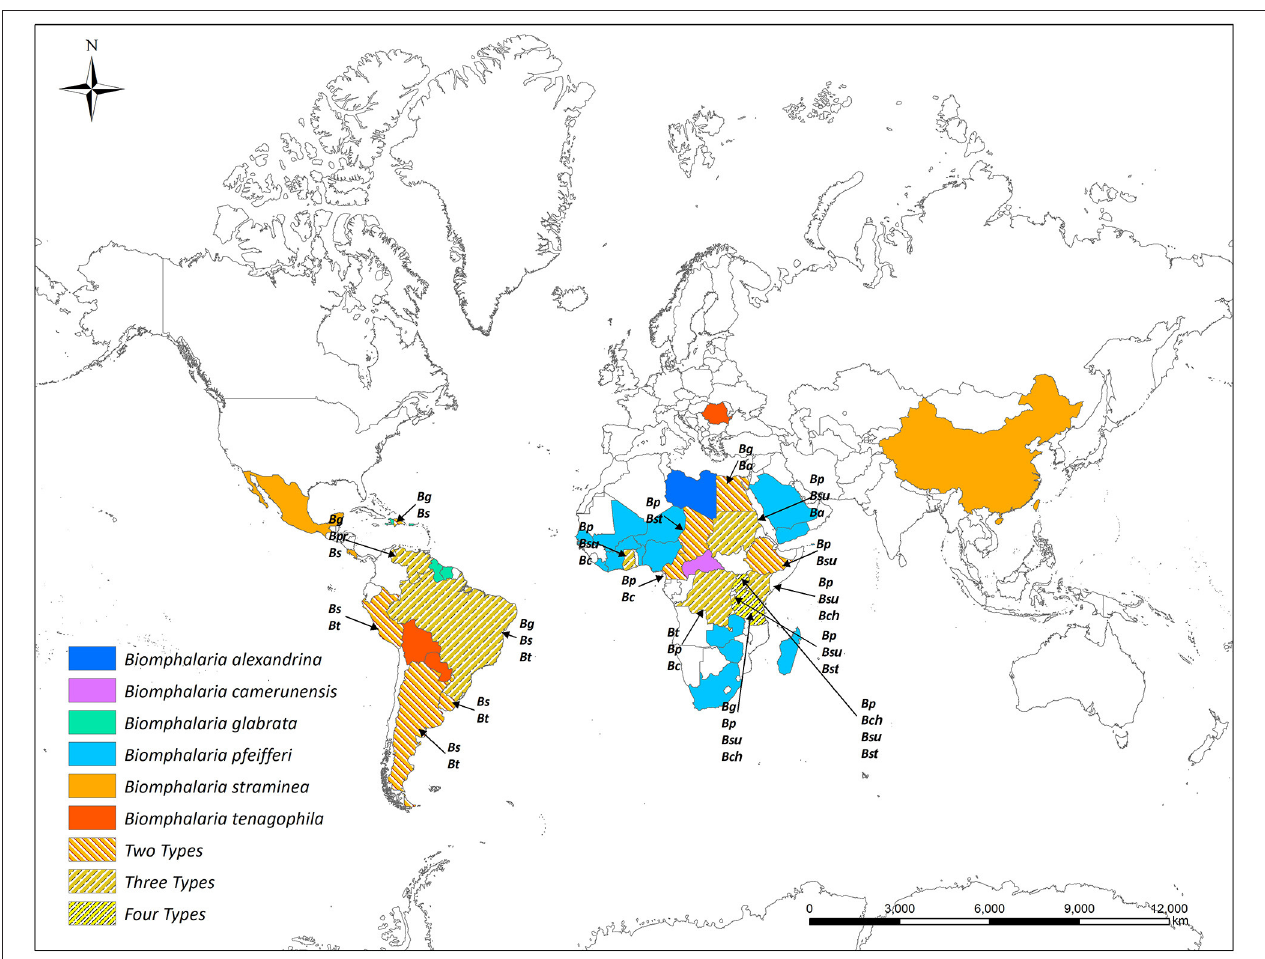
FIGURE 1 | Global distribution of susceptible species of Biomphalaria (country level). Ba , Biomphalaria alexandrina ; Bc , Biomphalaria camerunensis ; Bch , Biomphalaria choanomphala Bg , Biomphalaria glabrata ; Bp , Biomphalaria pfeifferi ; Bpr , Biomphalaria prona ; Bs , Biomphalaria straminea ; Bst , Biomphalaria stanleyi ; Bsu , Biomphalaria sudanica ; Bt , Biomphalaria tenagophila